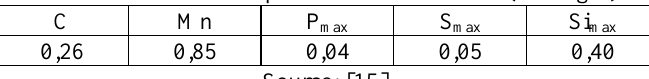
Table 1: Chemical composition of carbon steel (% weight).